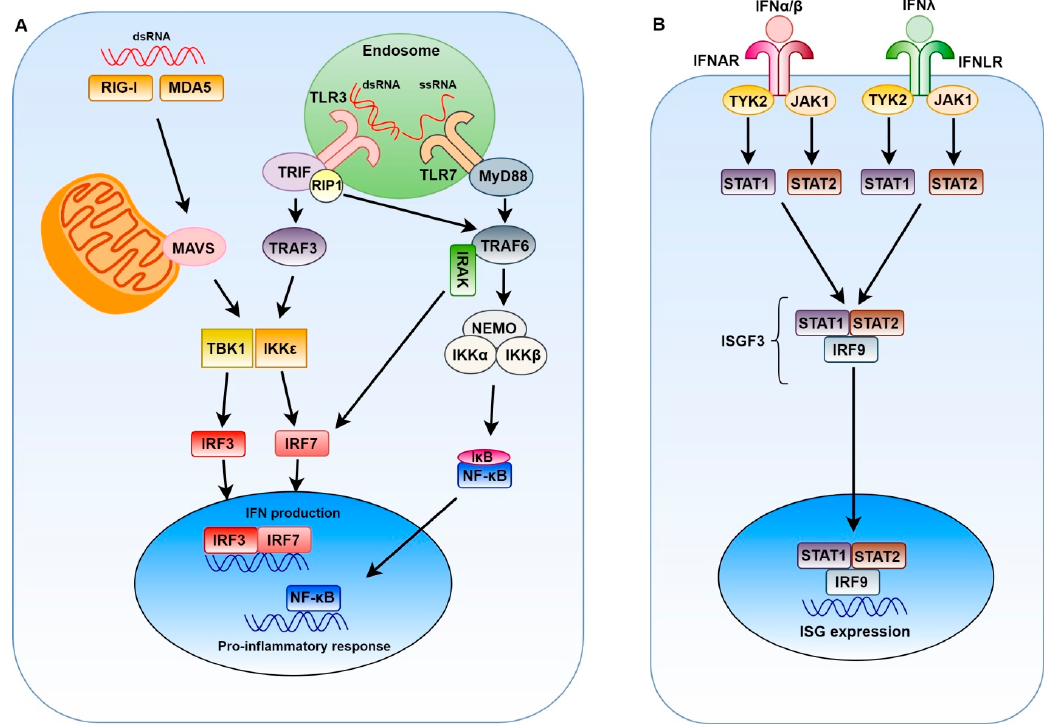
Figure 1. Innate immune response to positive-stranded RNA viruses and interferon (IFN) signalling.